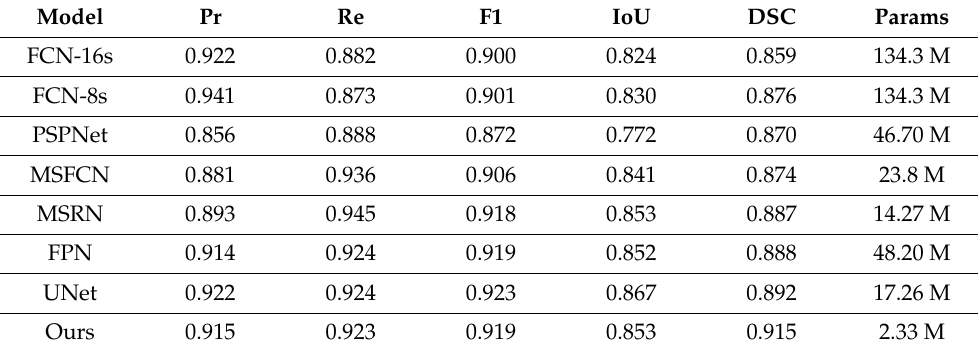
Figure 9. The effects of different segmentation models for osteosarcoma MRI images. Table 3. Index parameter values of different